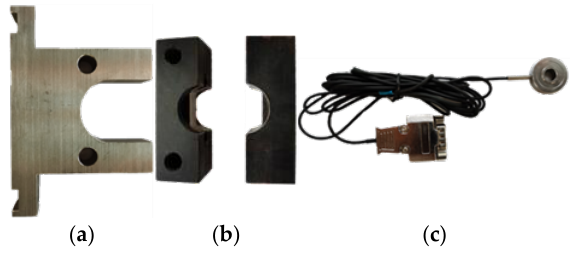
Figure 2. Anti-vibration bar assembly: ( a ) bar support; ( b ) AVB; ( c ) force transducer.